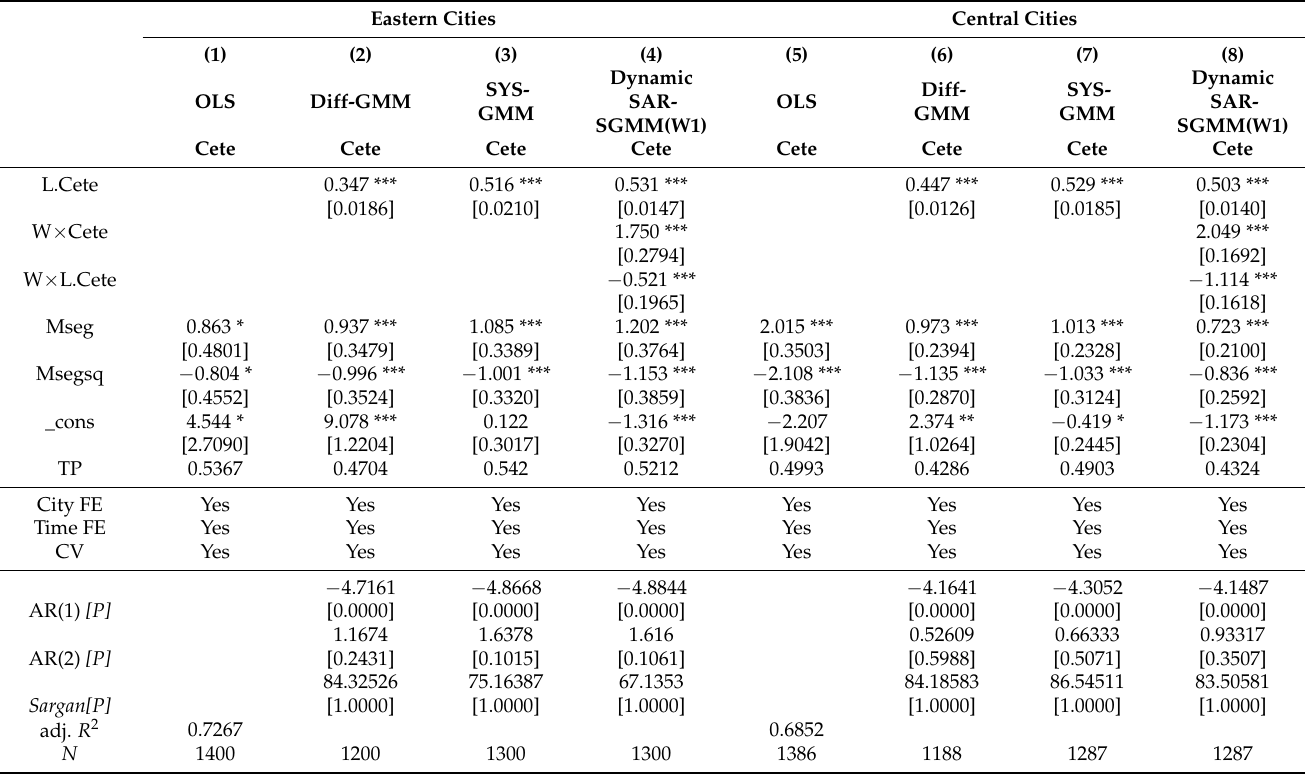
Table 9. Heterogeneity analysis regression